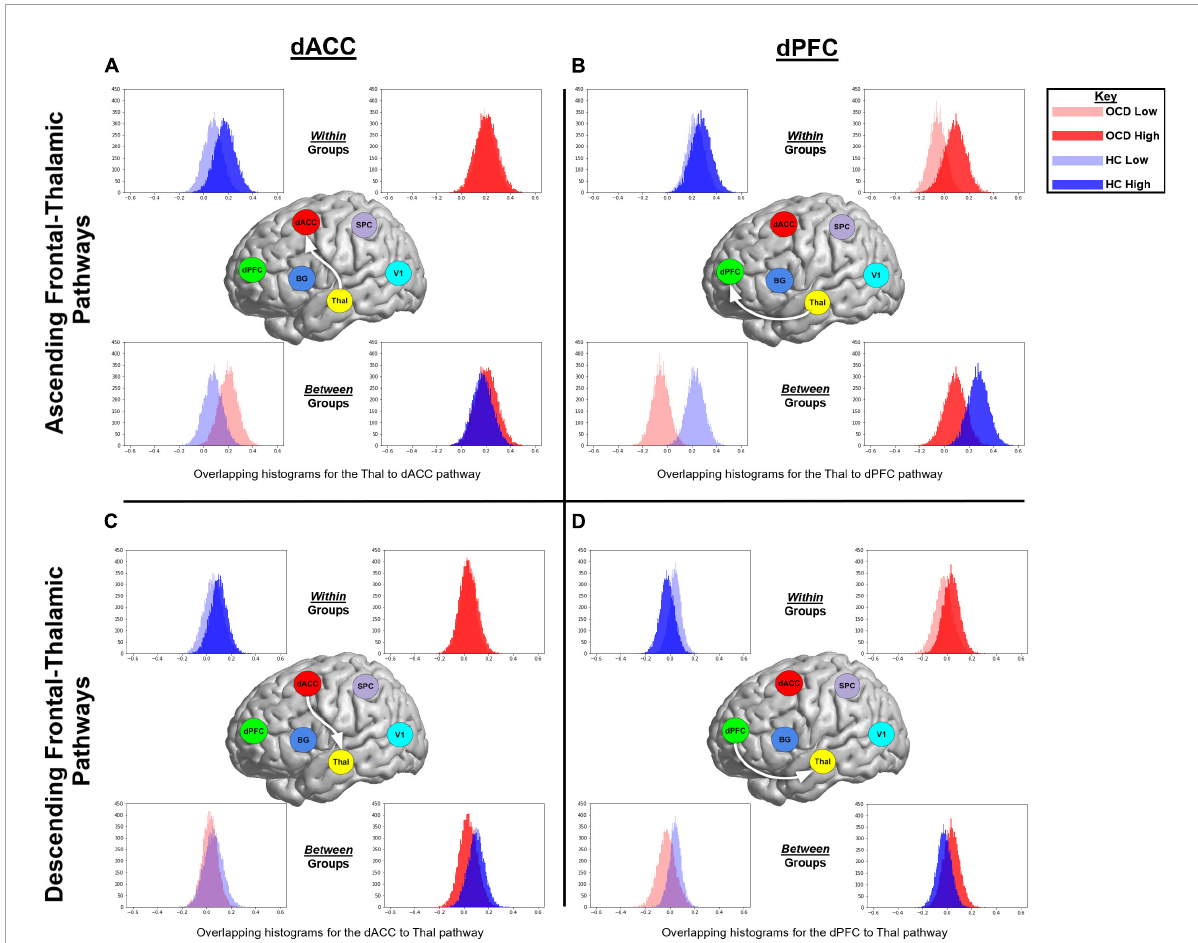
FIGURE5 The histograms were generated from extracting 20,000 BMA samples in Occam’s window, and highlight speculative trends associated with within or between group parameter estimates of contextual modulation. Data from OCD are represented in red, while data from HC are in blue. Data from the more demanding attention condition are represented by opaque colors, while data from the less demanding condition in transparent colors. The figure represents ascending and descending fronto-thalamic pathways and is organized in four panels: each column represents pathways involving either the dACC or the dPFC, and each row represents the ascending (from the thalamus) or descending (to the thalamus) pathway. In each panel, histograms are presented twice; initially to depict within group trends in each of the task conditions (top row) and then to depict between group trends in each of the conditions (bottom row)